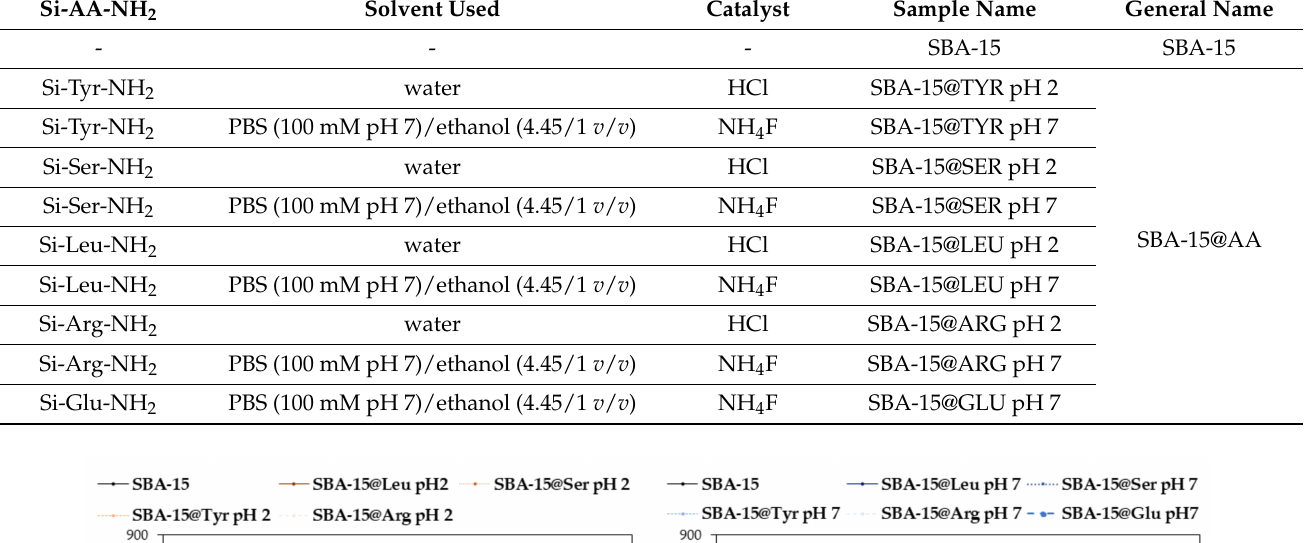
Table 1. Summary of the functionalized materials, the functionalization conditions used and the denoted name.